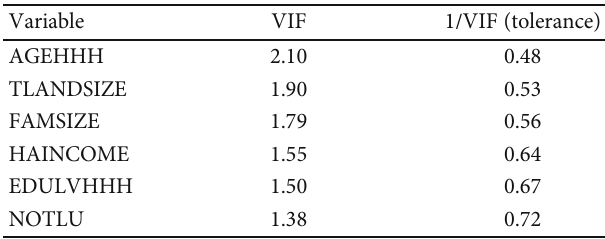
Table 3: Variance in fl ation factor of continuous explanatory variables.